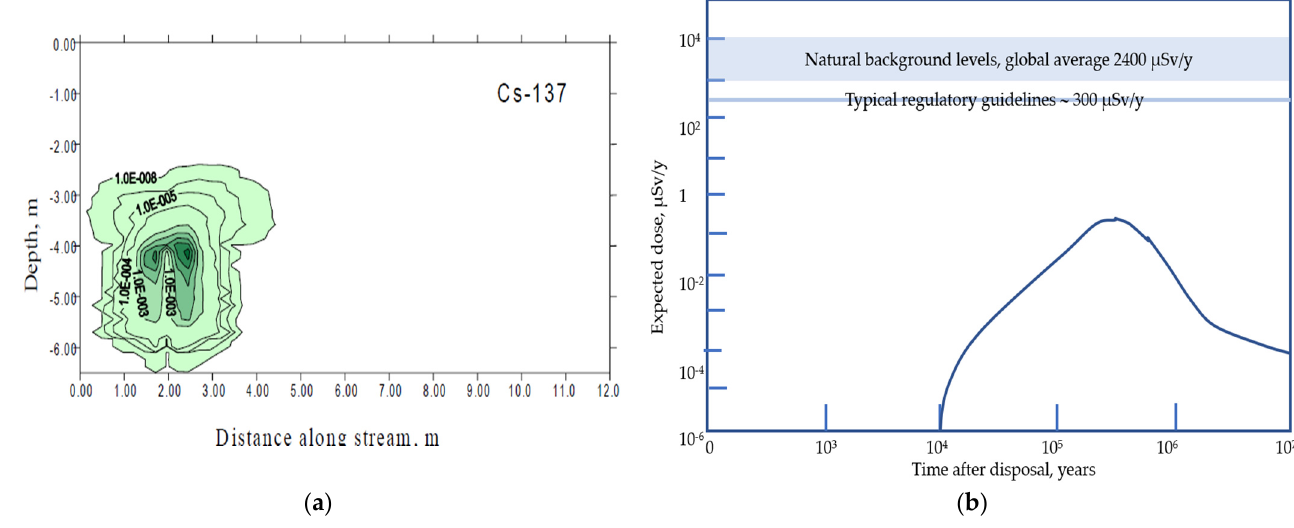
Figure 10. Typical safety analysis report (SAR) results of expected doses: ( a ) Expected concentration of radionuclides (Ci/m 3 ) after 100 years for an infiltrating stream flowing through a disused sealed radioactive source’s (DSRS) borehole disposal facility; ( b ) Expected doses to population D exp from a hypothetical geological disposal facility (GDF).